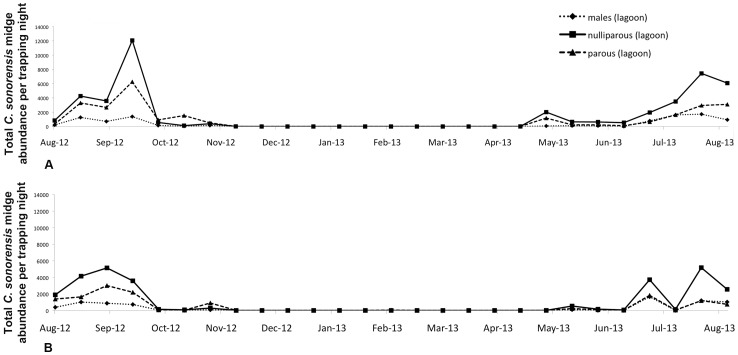
Seasonal abundance of adult Culicoides sonorensis distinguished by sex and parity (males- dotted line; parous-dashed line; nulliparous-solid line) for Farm A (top) and Farm B (bottom).